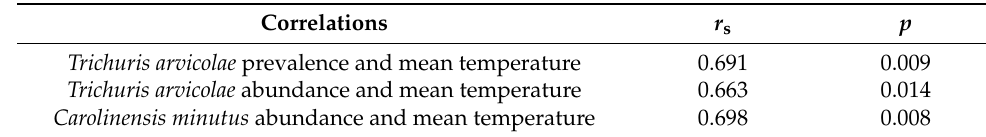
Table 15. Values of Spearman Correlation Coefficient ( r s ), with associated probabilities ( p ), between climate variables (temperature and rainfall) and diversity (species richness and Brillouin index), prevalence and abundance. Only significant results are